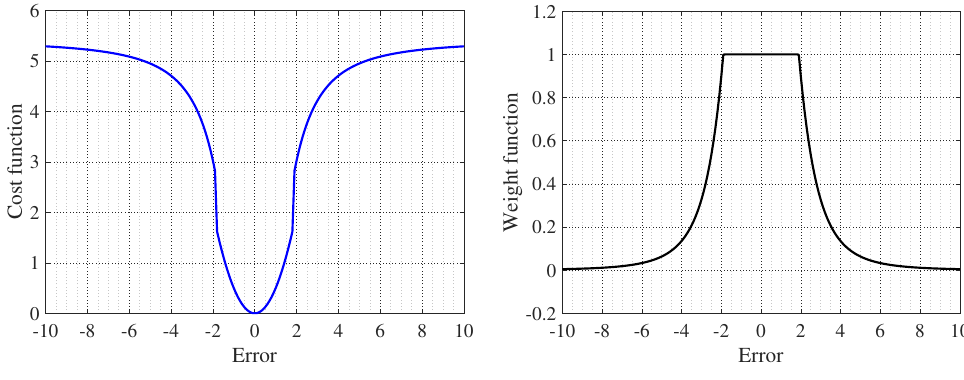
Figure 3. Cost and weight functions of a DCS